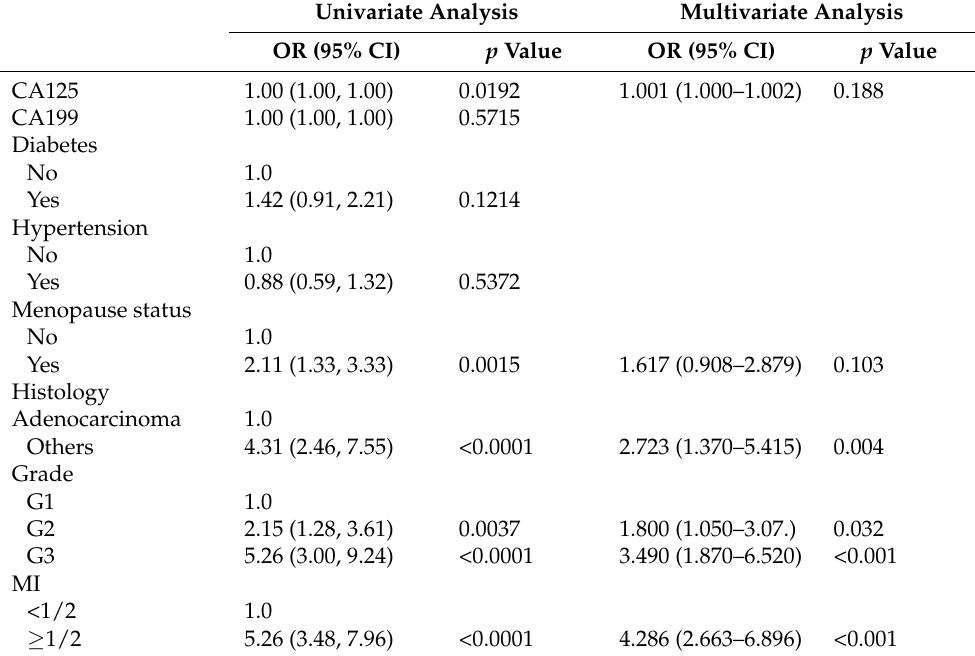
Table 3. Cont. Univariate Analysis Multivariate Analysis